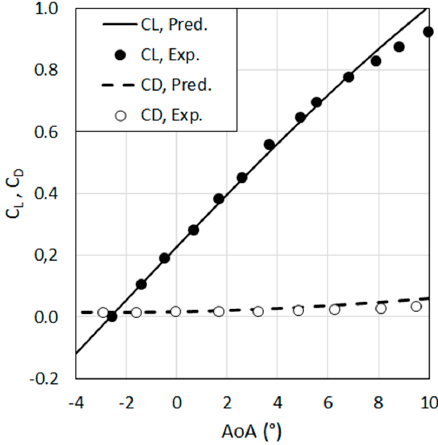
Figure 6. Comparison of predicted lift and drag coefficients with the measured values for the profile NREL-S822 of Selig et al. [51] (Re = 400,000).